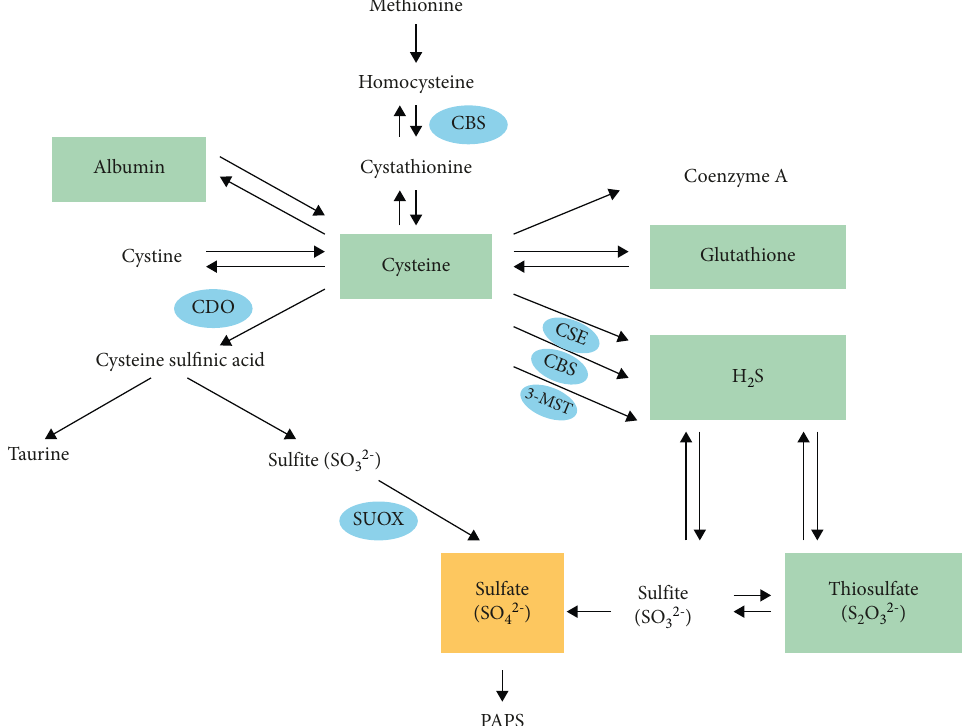
Figure 2: Sulfur metabolism diagram. The essential sulfur amino acid methionine converts to cysteine, a precursor to albumin, cystine, coenzyme A, glutathione, hydrogen sulfite (H 2 S), taurine, and sulfate (SO 42 − ). H 2 S can convert to thiosulfate (S 2 O 32 − ) and sulfite (SO 32 − ), which are oxidised to sulfate. The enzyme cystathionine- β -synthase (CBS) converts homocysteine to cystathionine, while cysteine dioxygenase (CDO) is responsible for the conversion of cysteine to cysteine sulfinic acid. Sulfite oxidase (SUOX) oxidises sulfite to sulfate. H 2 S is generated from cysteine by three different pathways through either CBS, cystathionine- c -lyase (CSE), or 3-mercaptopyruvate sulfurtransferase (3-MST). Adapted with permission by CC by 4.0